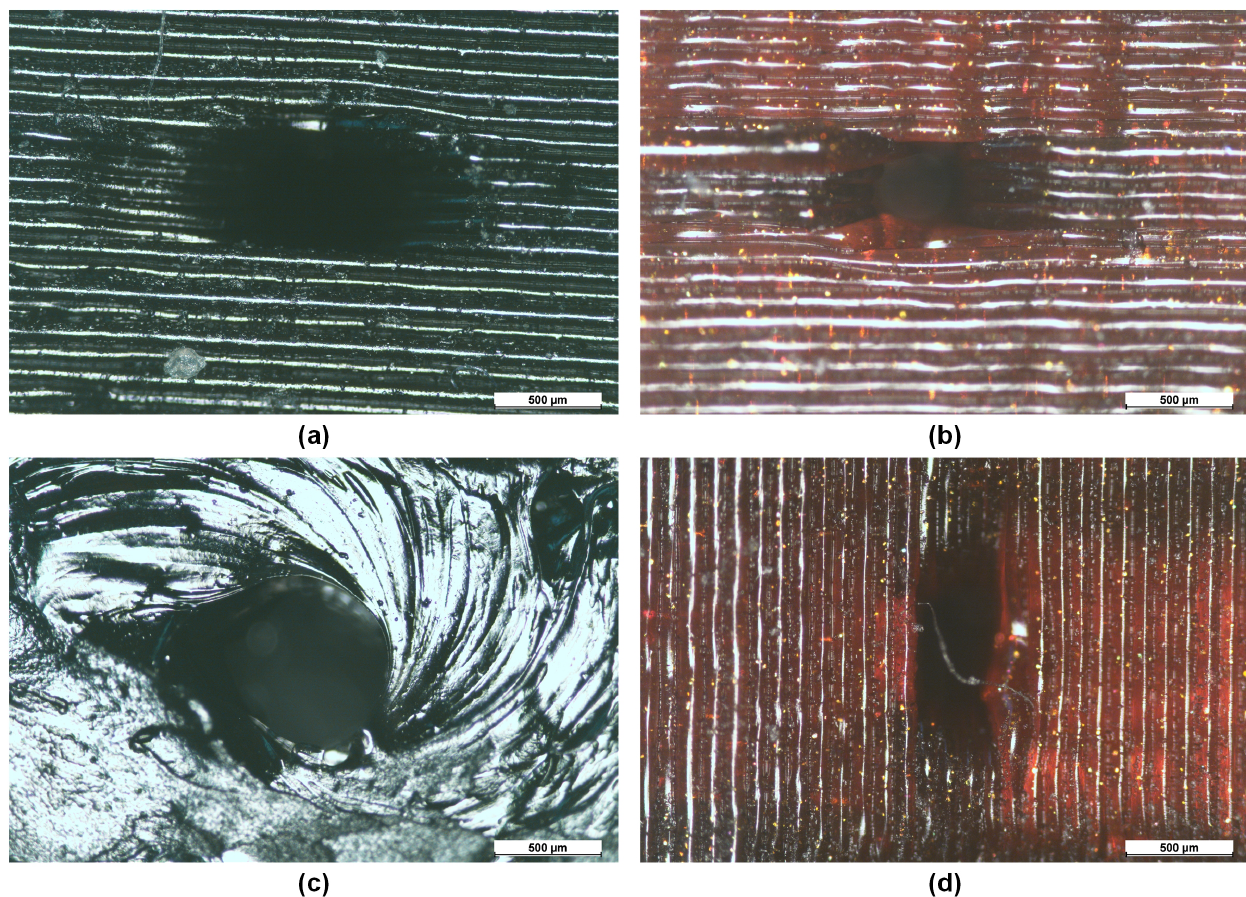
Figure 6. Comparison between printing with Prusa and UP02: ( a ) Horizontal printing by UP02 ( b ) Horizontal printing by Prusa ( c ) Vertical printing by UP02, and ( d ) Vertical printing by